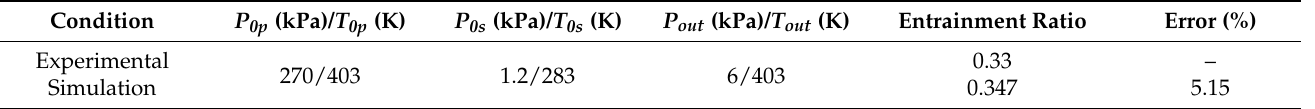
Table 2. Comparison of numerical simulation and experimental results of the induced